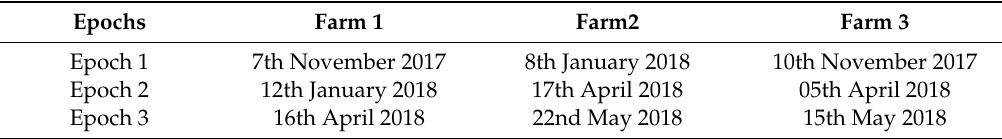
Table 2. Dates of acquisition of Unmanned Aerial Vehicles (UAV) imagery for the three